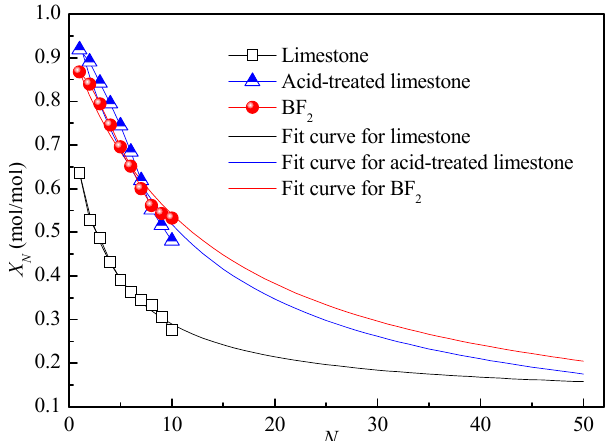
Figure 1. Cyclic carbonation conversions of CaO-based materials (calcination: 850 °C, pure N 2 , 10 min; carbonation: 850 °C, pure CO 2 , 5 min). Table 2. Fitting parameters for multicyclic energy storage according to Equation